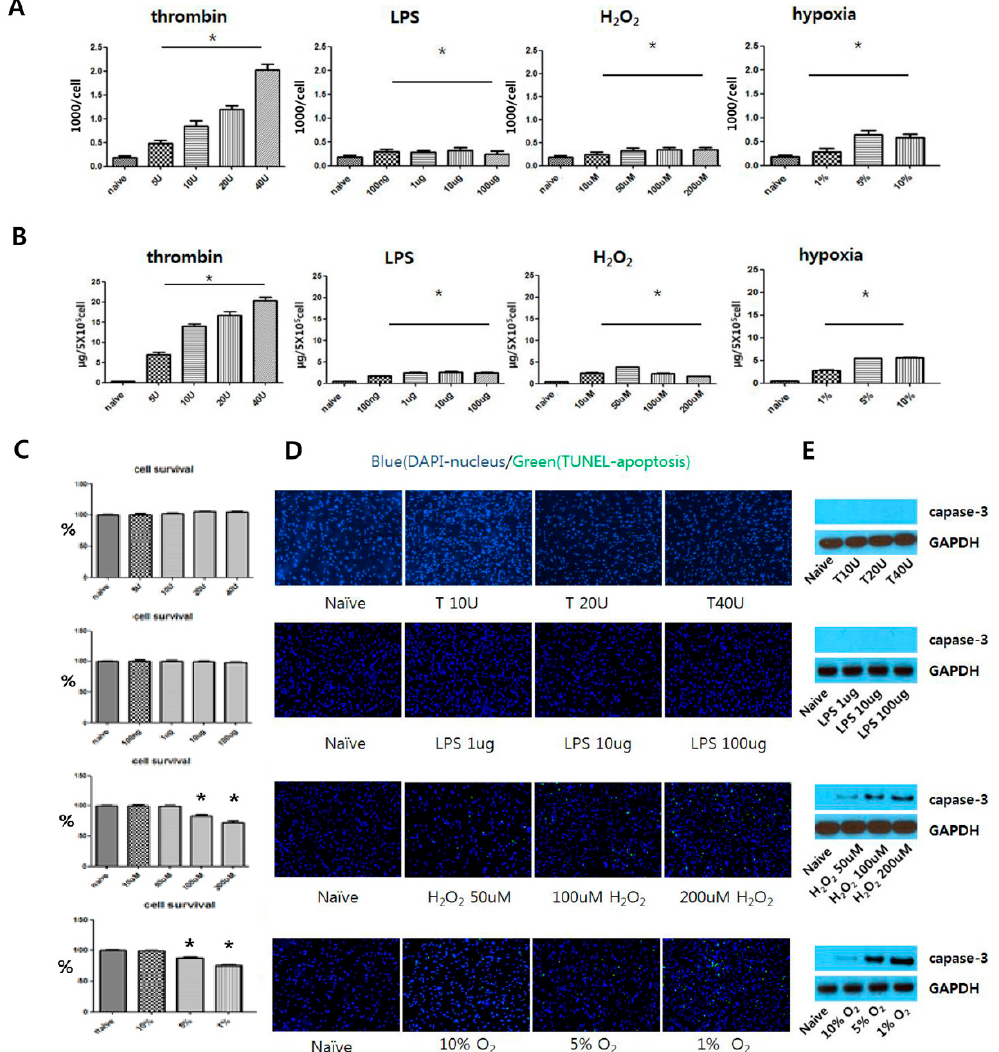
Figure 2. Effects of various preconditioning for umbilical cord blood-derived mesenchymal stem cells (UCB-MSCs) on exracellular vesicle(EV) production, cell viability, and cell death. MSCs were preconditioned by treatment of thrombin (5 U, 10 U, 20 U, and 40 U), LPS (100 ng, 1 μ g, 10 μ g, and 100 μ g), H 2 O 2 (10 μ M, 50 μ M, 100 μ M, and 200 μ M), and hyoxia (10% O 2 , 5% O 2 , 1% O 2 ) for 6 h, respectively. ( A ) Representative nanoparticle tracking (NTA) analysis for isolated EVs expressed with total counts of EVs divided by the total number of MSCs. ( B ) Total protein concentration of isolated EVs from 5 × 10 5 MSCs measured by the Bradford method. ( C ) Each preconditioning status was processed for 6 h and analyzed by the MTT assay after 24 h. ( D ) Terminal deoxynucleotidyl transferase dUTP nick end labeling (TUNLE) staining for MSCs in each culture condition. TUNEL-positive cells were labeled with fluorescein isothiocyanate(FITC)(green) and the nuclei with DAPI (blue). ( E ) Representative Western blot for caspase-3 expression of MSCs in each preconditioning status. Data are presented as mean ± SEM. Statistical analyses were carried out using a One-way Analysis of Variance (ANOVA). The asterisk(*) indicates the p < 0.05 compared with naïve UCB-MSCs.